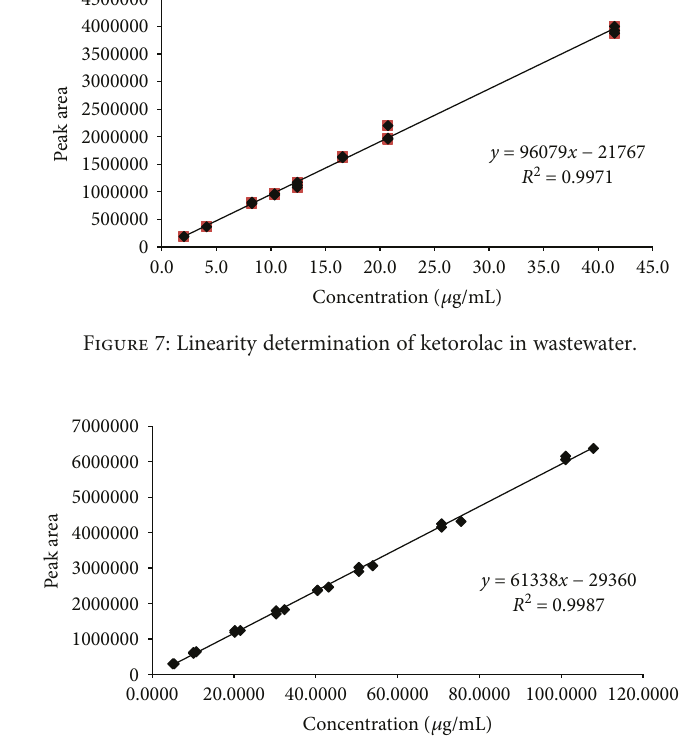
Figure 8: Linearity of ketorolac degradation products. Table 5: Accuracy results for ketorolac in wastewater.